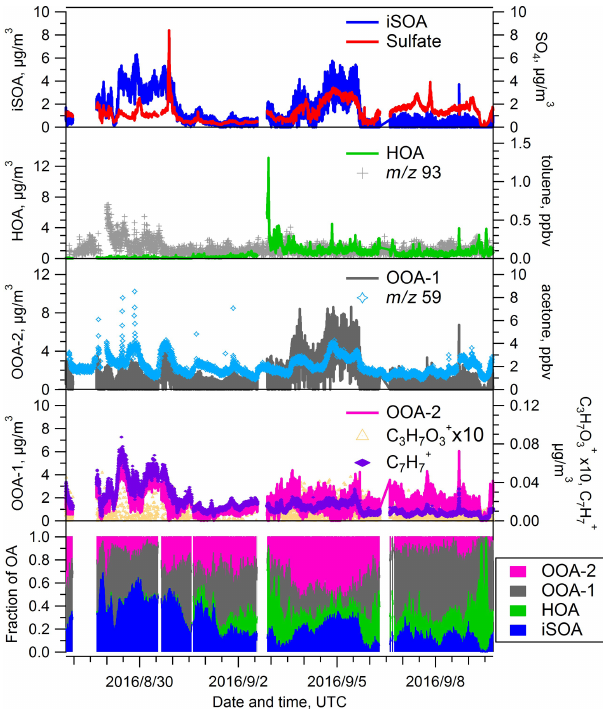
Figure 7. Time series of PMF factors extracted from the AMS data for the summer IOP. Time traces of additional species used to eval- uate the identity of the PMF factors are also